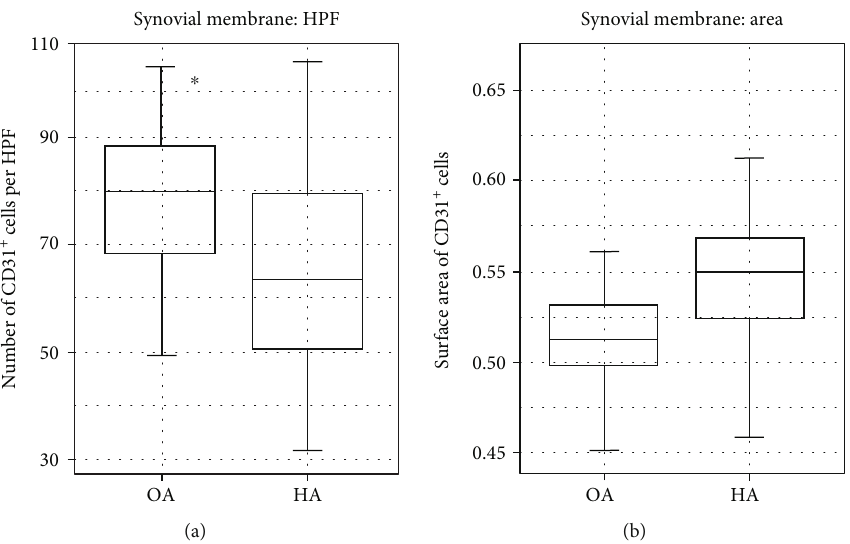
Figure 7: The average number of the CD31 + cells per HPF (a) and its occupied surface area (b) in the synovial membrane. The data has been presented as a mean value ± standard deviation (SD). ∗ p < 0 : 05 . OA: osteoarthritis; HA: hemophilic